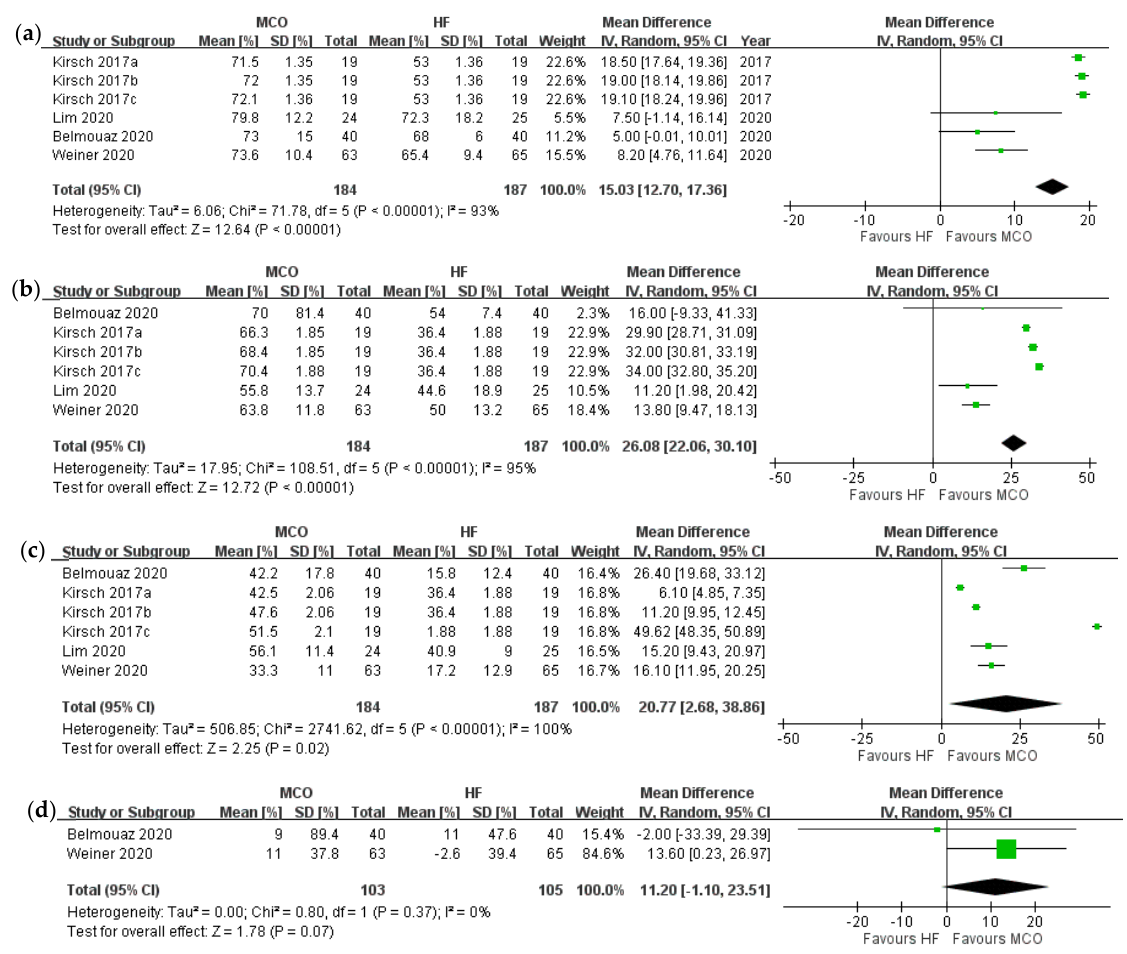
Figure 2. Forrest plot of reduction ratios over different middle molecules: ( a ) reduction ratio of beta 2-mircoglobulin, ( b ) reduction ratio of kappa free light chain, ( c ) reduction ratio of lambda free light chain, ( d ) reduction ratio of interleukin-6. Kirsch 2017a = MCO prototype AA; Kirsch 2017b = MCO prototype BB; Kirsch 2017c = MCO prototype CC.